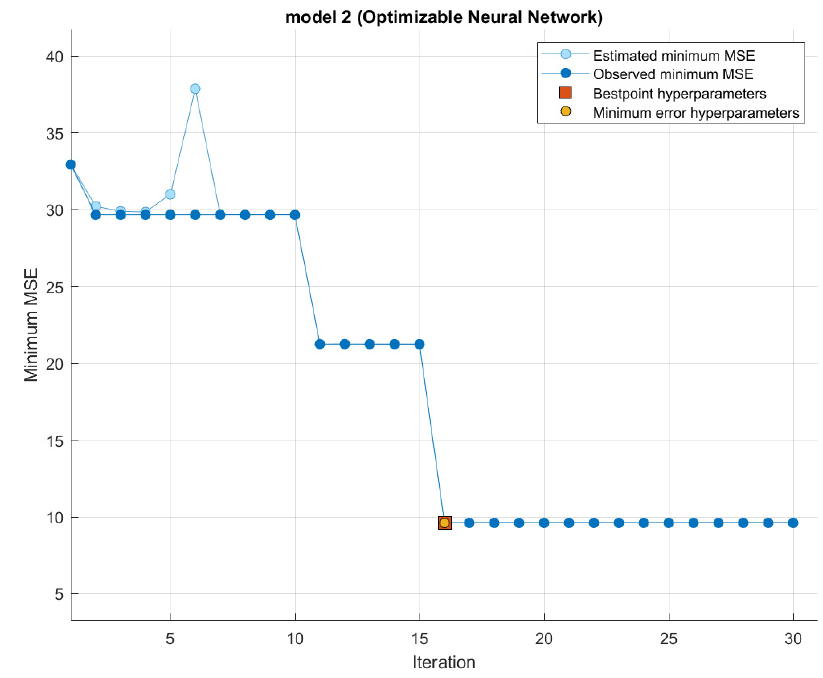
Figure 5. Optimized Wide Neural Network.